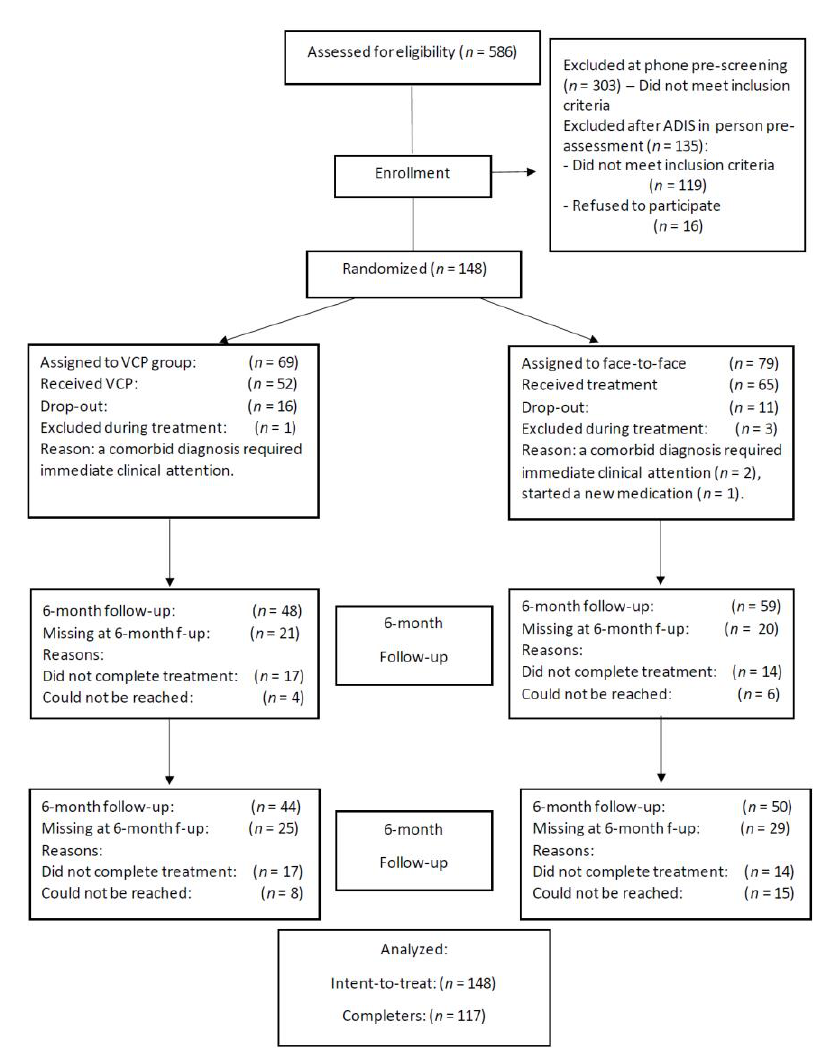
Figure 1. CONSORT flow chart of participation in the randomized control